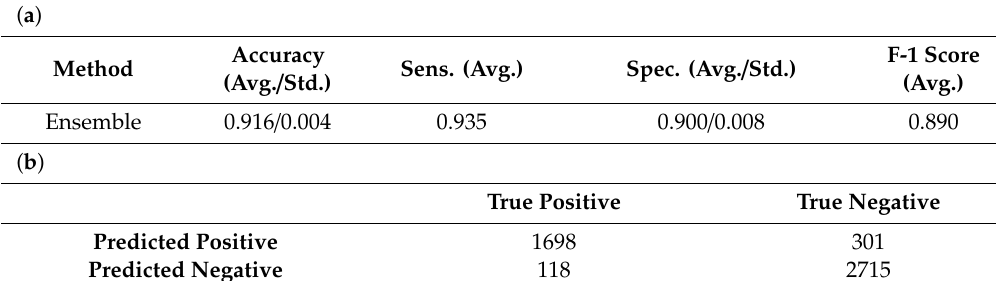
Table 6. Performance measurement ( a ) and the confusion matrix of one test fold ( b ) for ensemble approach on test images. Positive: non-cervix image. (Sens. = Sensitivity, Spec. = Specificity, Std. = Standard deviation, Avg. = Average).